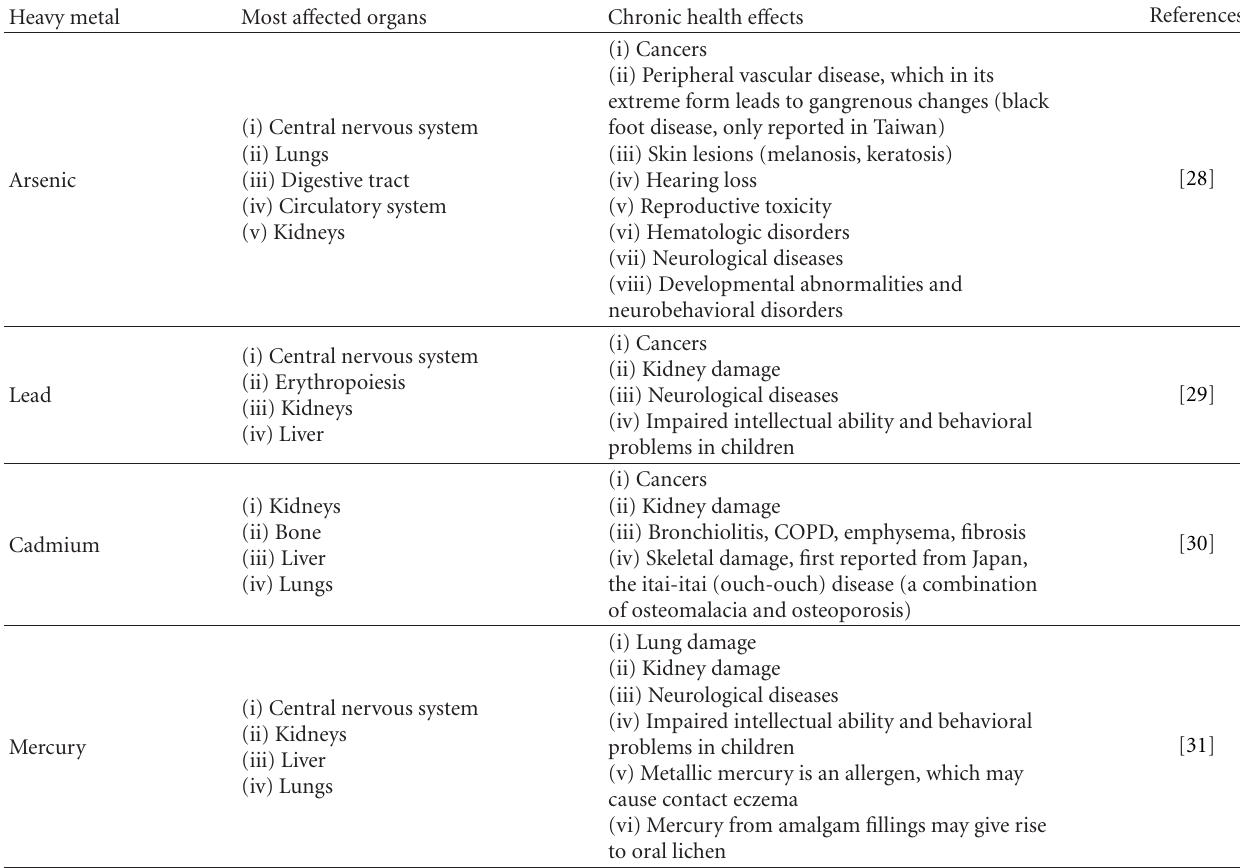
Table 2: Noncardiovascular harmful e ff ects of heavy